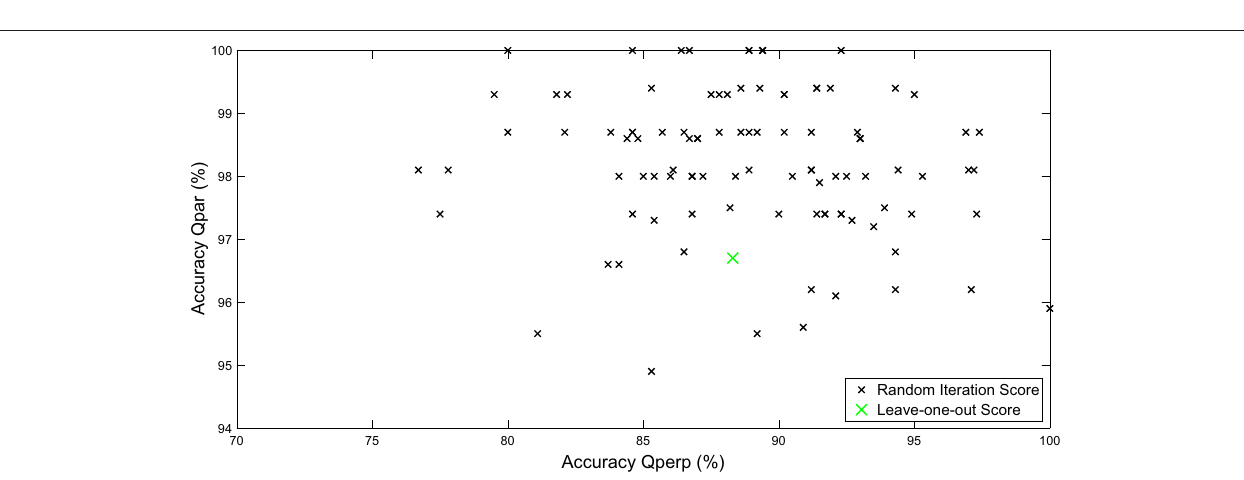
FIGURE 6 | Accuracy of the neural network for 100 random initialization of training/test set, with every point being one iteration. The x-axis represents the accuracy in quasi-perpendicular class and ranges from 70 to 100%. On the other hand, the y-axis shows the accuracy in the quasi-parallel class and ranges from 94 to 100%. Special indication of the leave one out result is marked in green color. The training of the shown neural networks includes the IMF